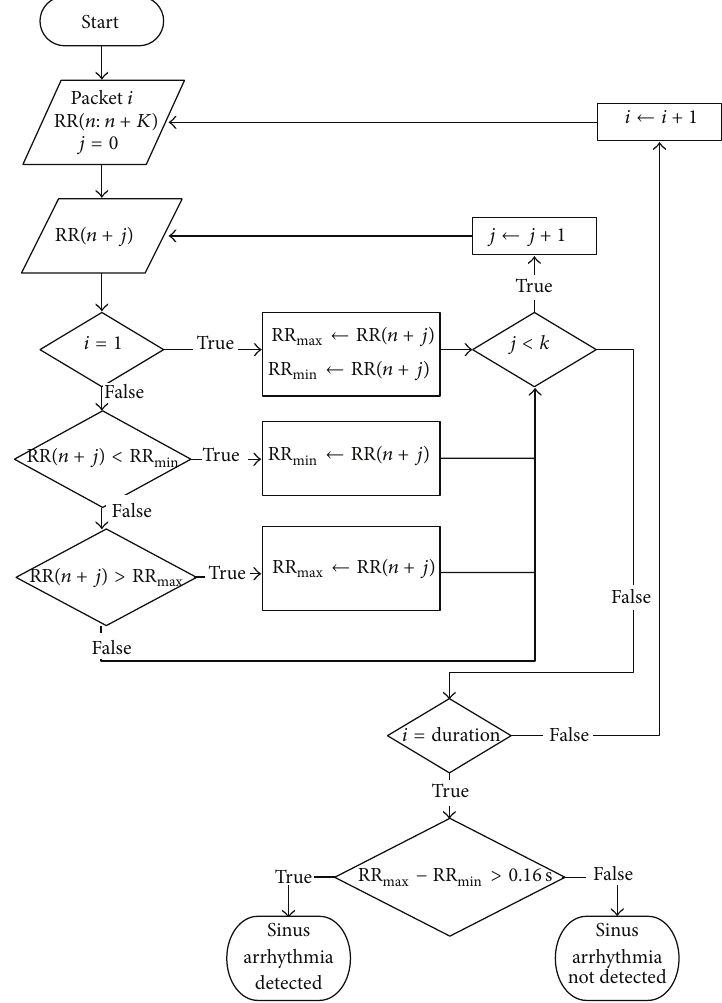
Figure 4: Sinus arrhythmia detection block